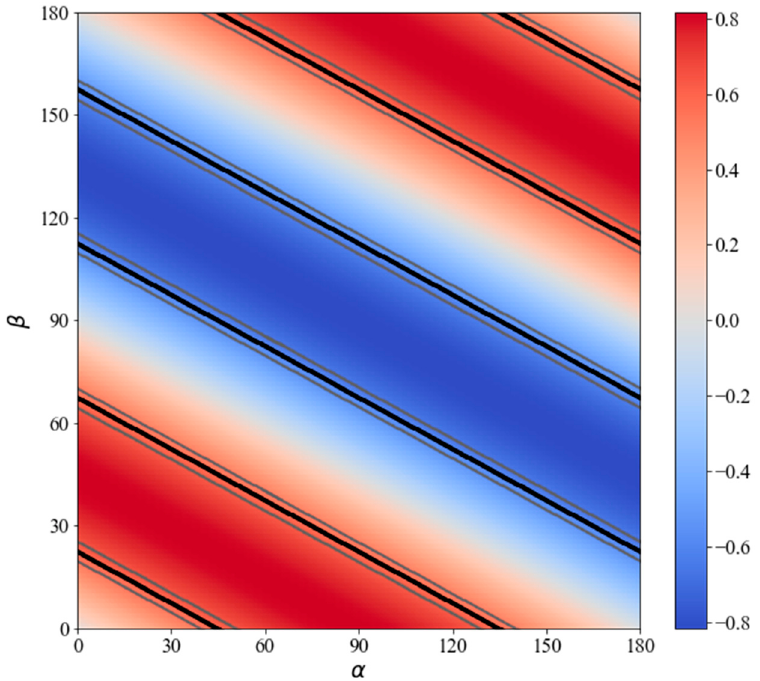
Figure 2. Dependence of the measured signal on the terahertz and probe radiation polarization angles ( α and β , respectively) relative to the ( − 211) axis of the (111)-cut zincblende detection crystal. It also can be seen from Figure 2 and the analysis of Equation (3) that the value of |𝐹 (cid:2869)(cid:2869)(cid:2869)(cid:3040)(cid:3028)(cid:3051) | = √(cid:2871) (cid:3406) 0.58 is achieved simultaneously for two orthogonal terahertz polarizations, if angles α and β satisfy the following condition: α + 2 β = 45 ◦ + 180 ◦ n , where n is an integer value (see the black lines in Figure 2, the grey lines represent a 10%